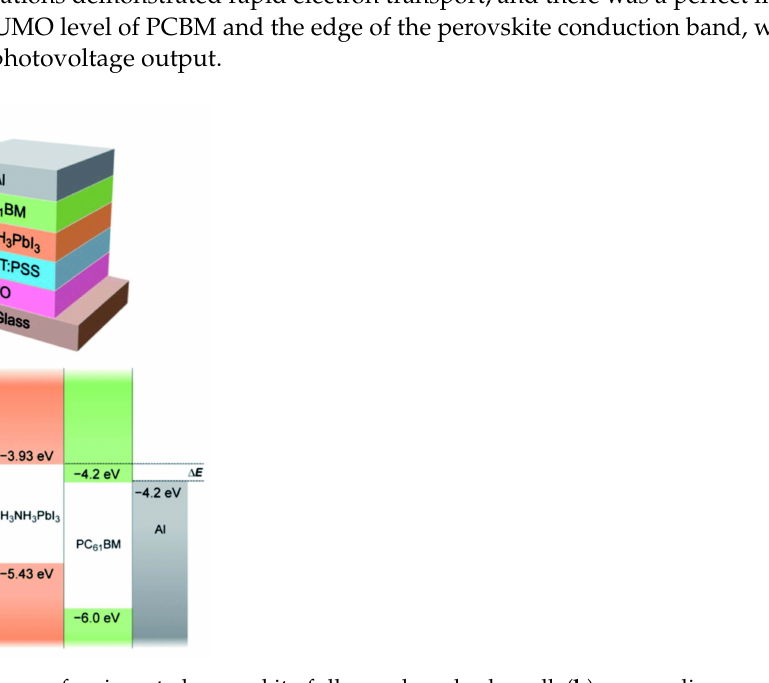
Figure 8. ( a ) Scheme of an inverted perovskite-fullerene-based solar cell; ( b ) energy diagram of the layers in the structure [146].